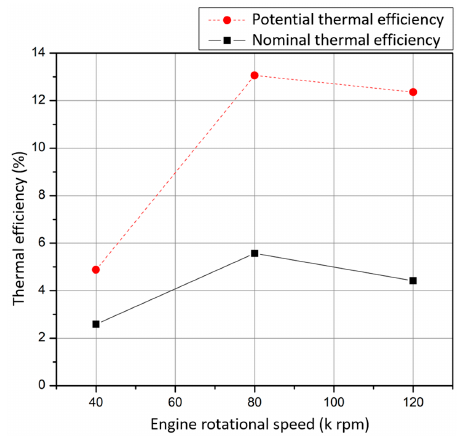
Figure 11. Total projected gas turbine thermal e ffi ciency improvement with hot section variable geometry systems based on average gas turbine